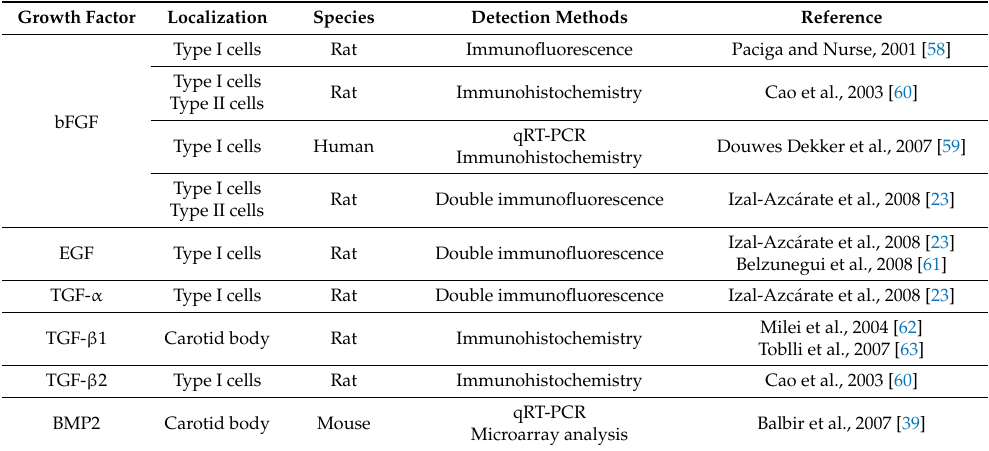
Table 6. Fibroblast growth factor, epidermal growth factor / transforming growth factor- α family, and transforming growth factor- β . Expression of bFGF, EGF, TGF- α , TGF- β , and BMP2 in the carotid body.